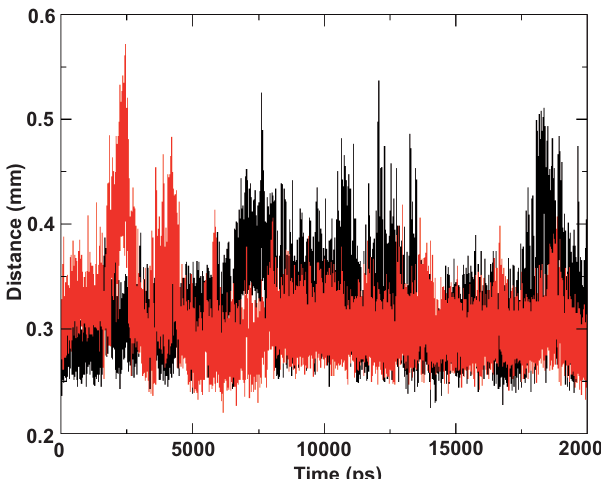
Figure 5. Distance of the amphipathic segment to the lipid leaflets. The 2KZQ is colored in black while the ideal helix model is colored in red. Amphipathic residues remain within 4 Å from the phosphate head group throughout the